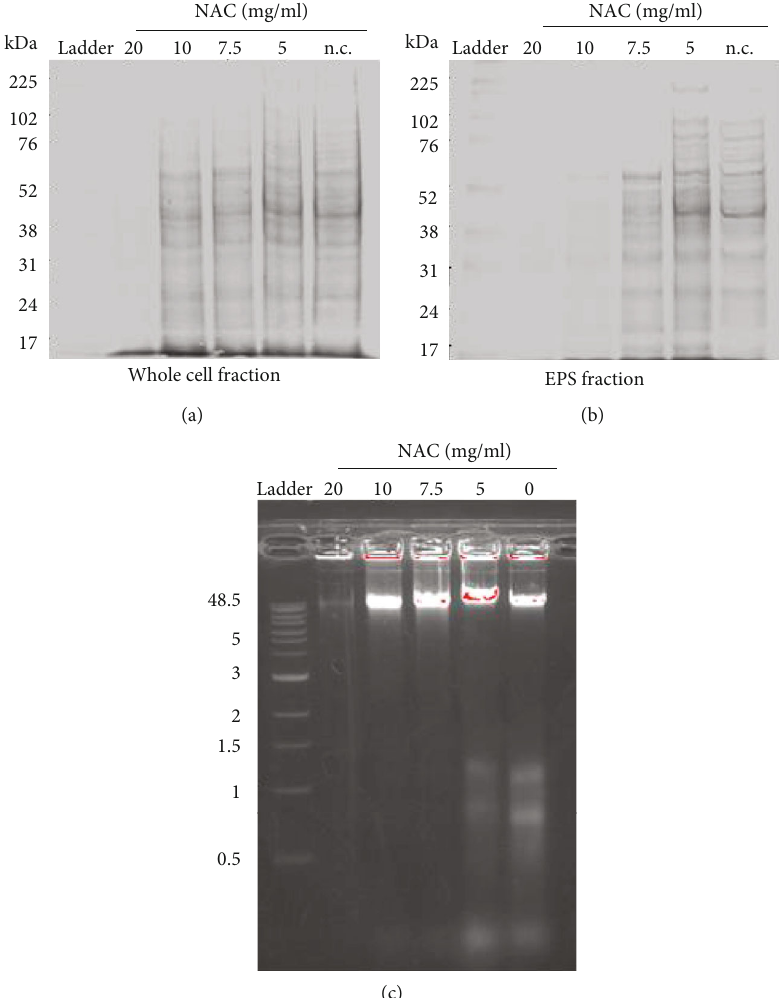
Figure 7: The e ff ect of NAC on the protein and DNA of the EPS. 24h chronic wound microbiome bio fi lm was treated with NAC at di ff erent concentrations for 24h. The same amount of bio fi lm inoculum was extracted and analyzed on 12% SDS-PAGE gels. (a) Whole protein extract. (b) Soluble protein component (EPS fraction). In the presence of 20mg/ml NAC, there were signi fi cantly less proteins both in the whole extract and in the soluble fraction. With 10mg/ml NAC, the protein in the whole extract was not di ff erent from that of the control whereas the protein in the supernatant was signi fi cantly decreased. NAC treatment with less than of 7.5mg/ml did not alter either the whole extract or the soluble proteins except for those above ~ 60kDa. (c) DNA components in the bio fi lm matrix were analyzed using 1% agarose gels. A prominent band was seen at 45.8kb with 5, 7.5, and 10 mg/ml NAC treatments. Treatment with 20mg/ml of NAC reduced the amount of DNA present in that band, and no other DNA bands were seen. The pattern of DNA in the EPS with 5mg/ml NAC treatment was similar to that of the control and showed not only the 45.8kb band but also other smaller bands: < 1.5 kb. These smaller bands were not seen with any of the other NAC treatments. We used biological triplicates for each treatment for SDS-PAGE